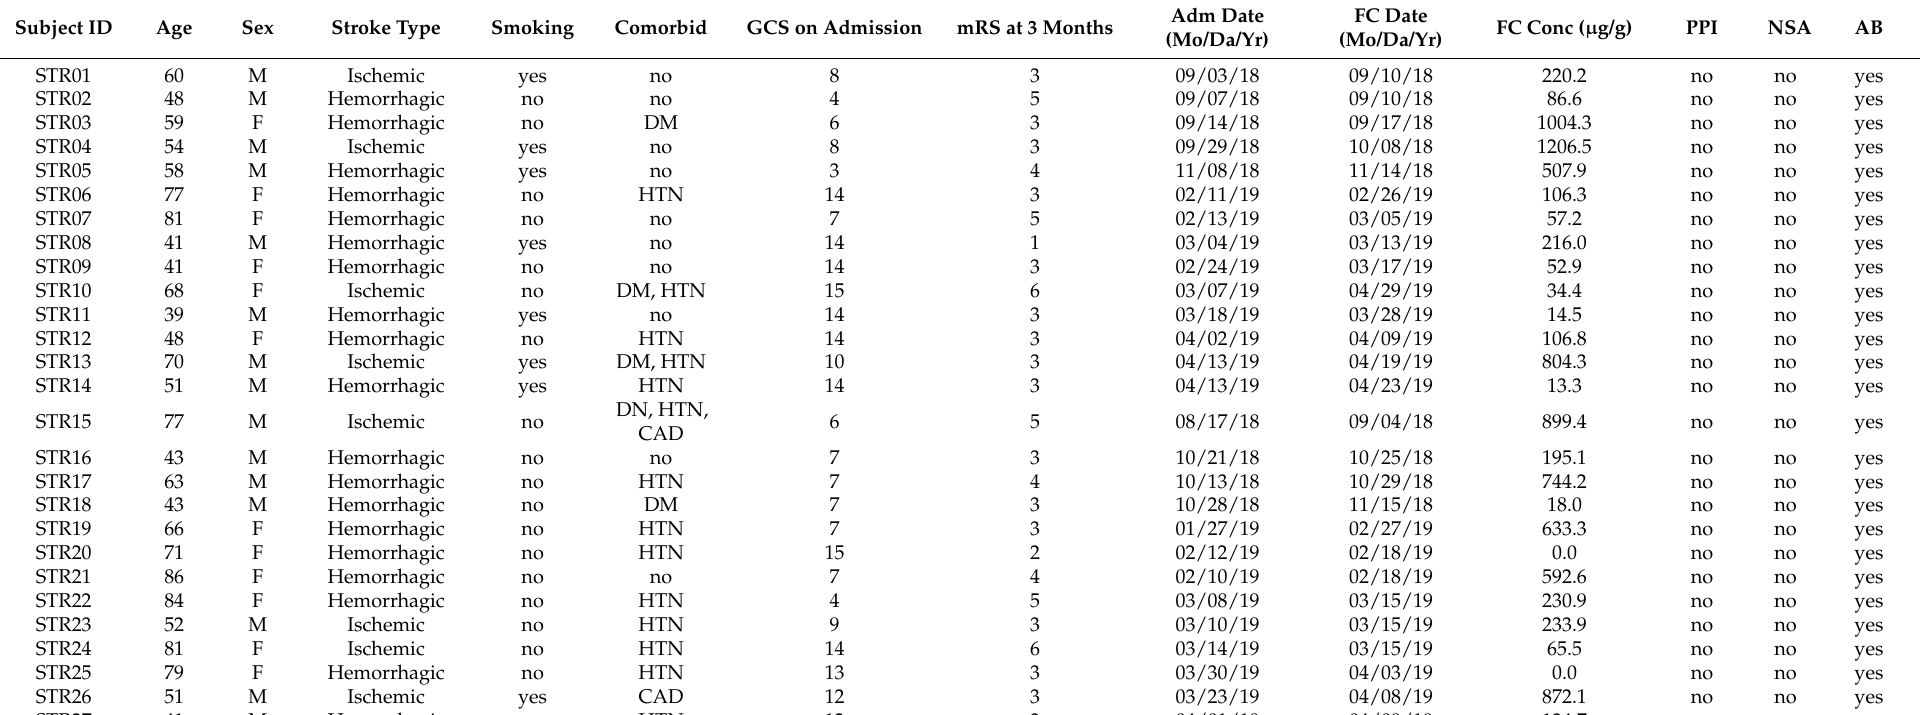
Table 2. Clinical characteristics of the stroke patients ( n =